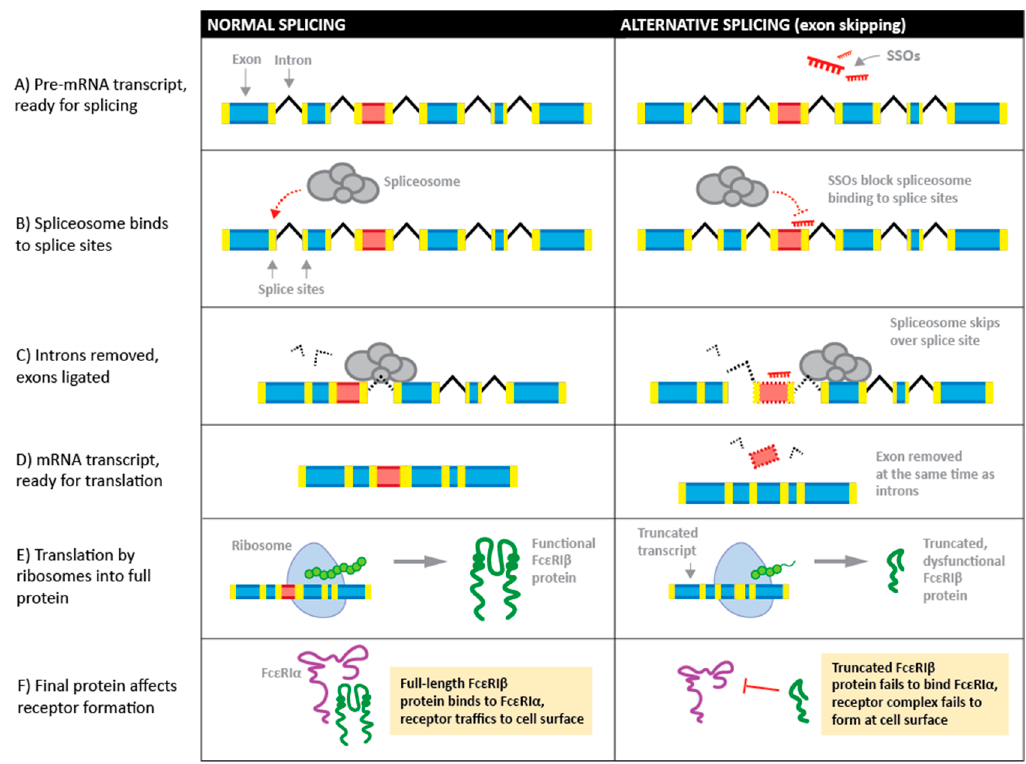
Figure 2. Process of alternative splicing to produce truncated Fc ε RI β using splice switching oligo- nucleotides (SSOs).